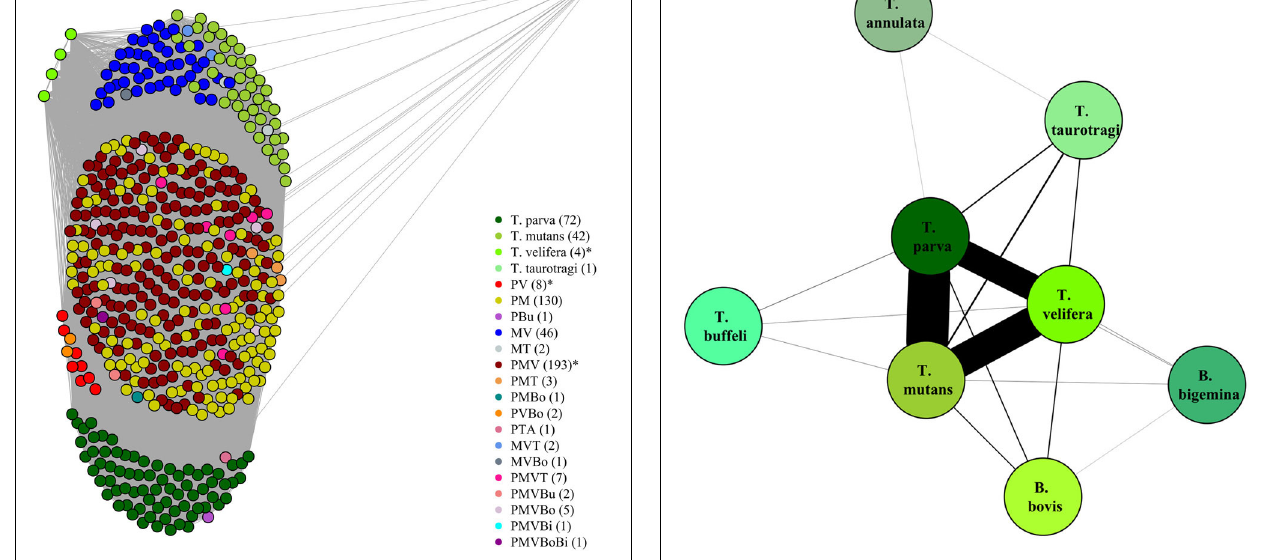
FIGURE 5 | Graphical representation of the structuring of host, using parasite network approach, for the dataset described in Salih et al. (2007). Theileria parva (P), T. mutans (M), T. velifera (V), T. taurotragi (T), T. buffeli (B), T. annulata (A), Babesia bovis (Bo) and B. bigemina (Bi). Each dot represent a host individual. Each color represent a parasite combination and the number of individual per combination is shown in brackets. Non-infected individuals were not shown. The asterisks highlight the significant combinations, which were found using the association screening approach.